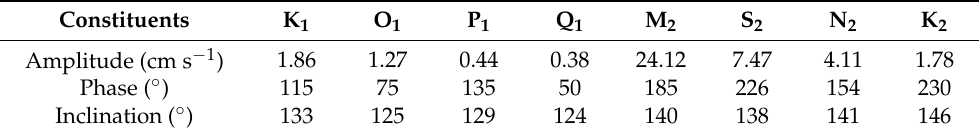
Table 1. Ellipse properties of eight major barotropic tidal